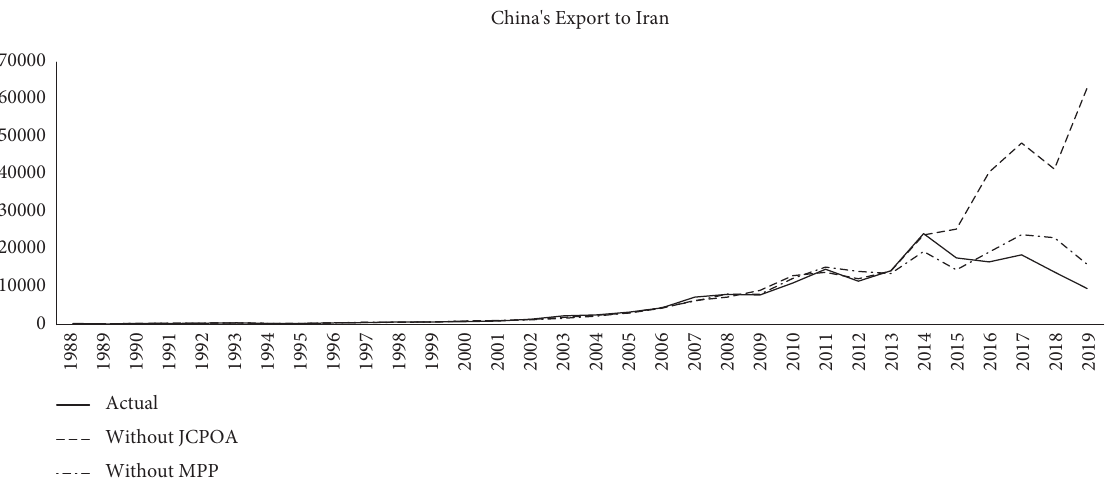
Figure 8: China’s export to Iran under diferent scenarios (1988–2019). Source: research estimations based on the IMF data on the direction of trade [23] and the World Development Indicators [21].